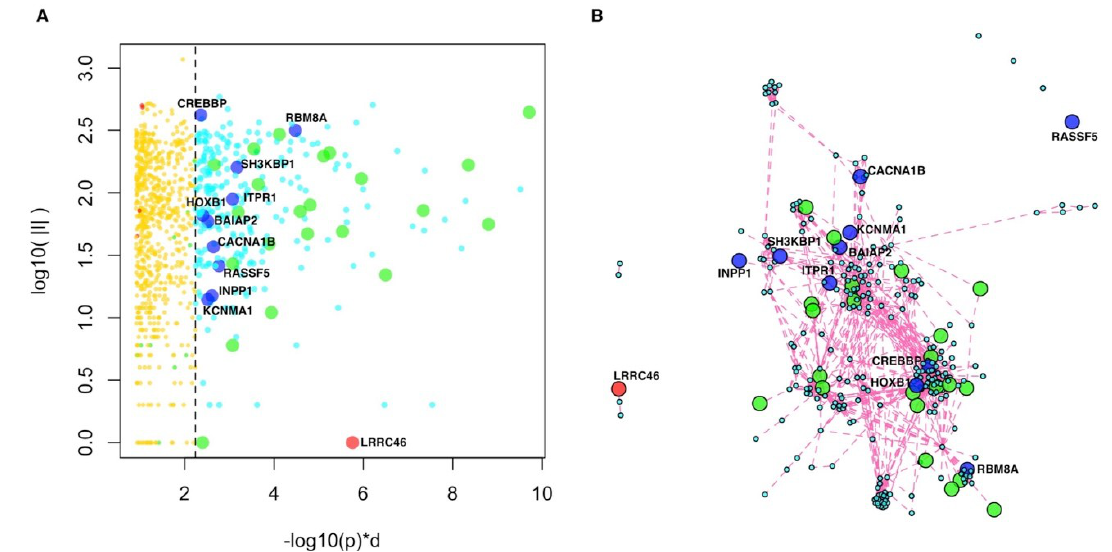
Figure 3. Integrative multi-omics analysis. ( A ) Global network diffusion scores (horizontal axis) and number of interactions (vertical axis) of the top ranking genes; the vertical dashed line separates the top 275 genes belonging to the INT-MODULE (higher scores, on the right) from the other genes (lower scores, on the left). ( B ) Network of the top 275 genes (INT-MODULE). Green circles: shared genes; blue circles: Genes included in SFARI categories 4 and 5; red circle: LRRC46 . Table 4. INT-MODULE genes SFARI. G: Genomics; E: Epigenomics; T: Transcriptomics. ** major; * minor. Im: Number of interactors within the INT-MODULE; SFARI score: “minimal evidence” (4), “hypothesized but untested” (5). Other modules: Reference of gene-networks studies that also associated the gene to ASDs.